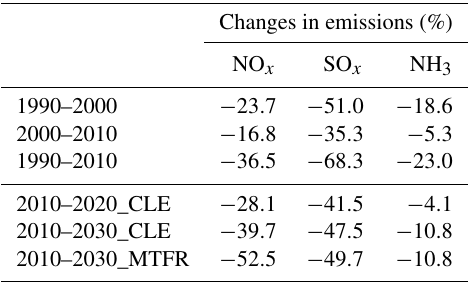
Table 2. Differences in emissions between various years and future